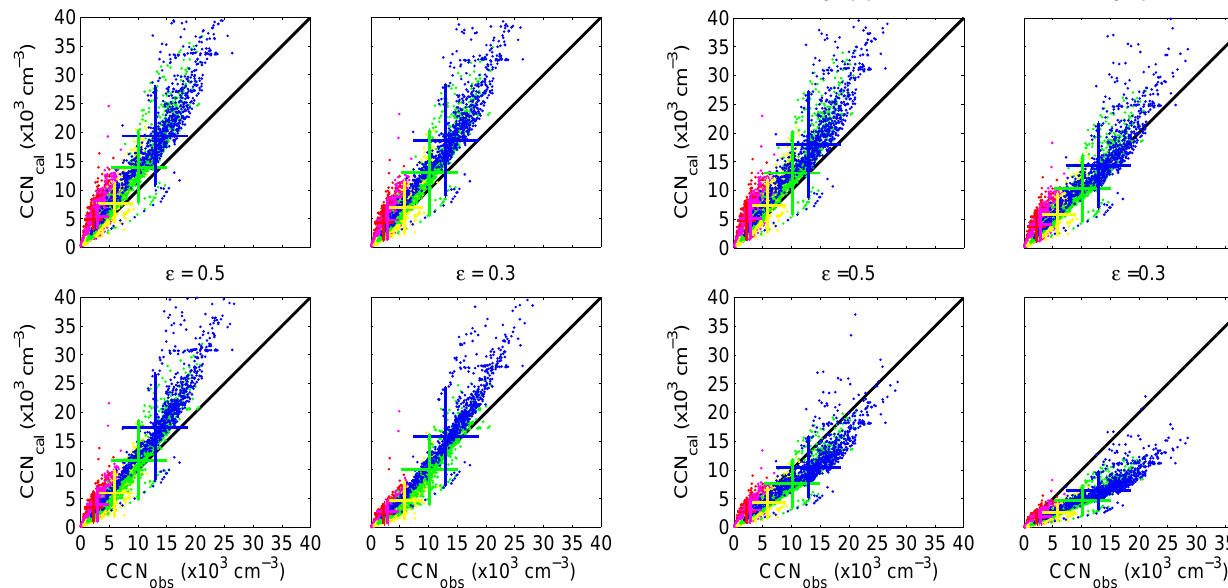
Table 1a. The best-fit mass fraction of ammonium